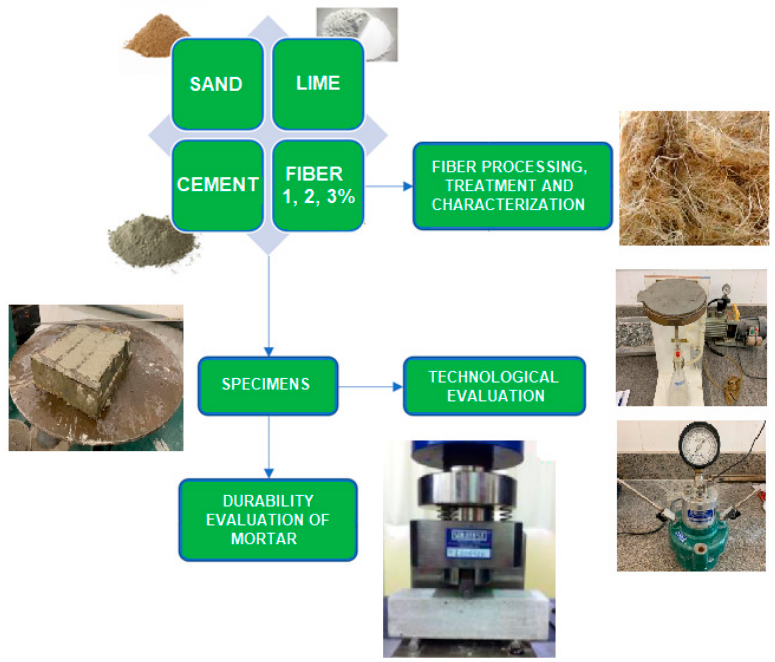
Figure 1. Experimental flowchart with photos.